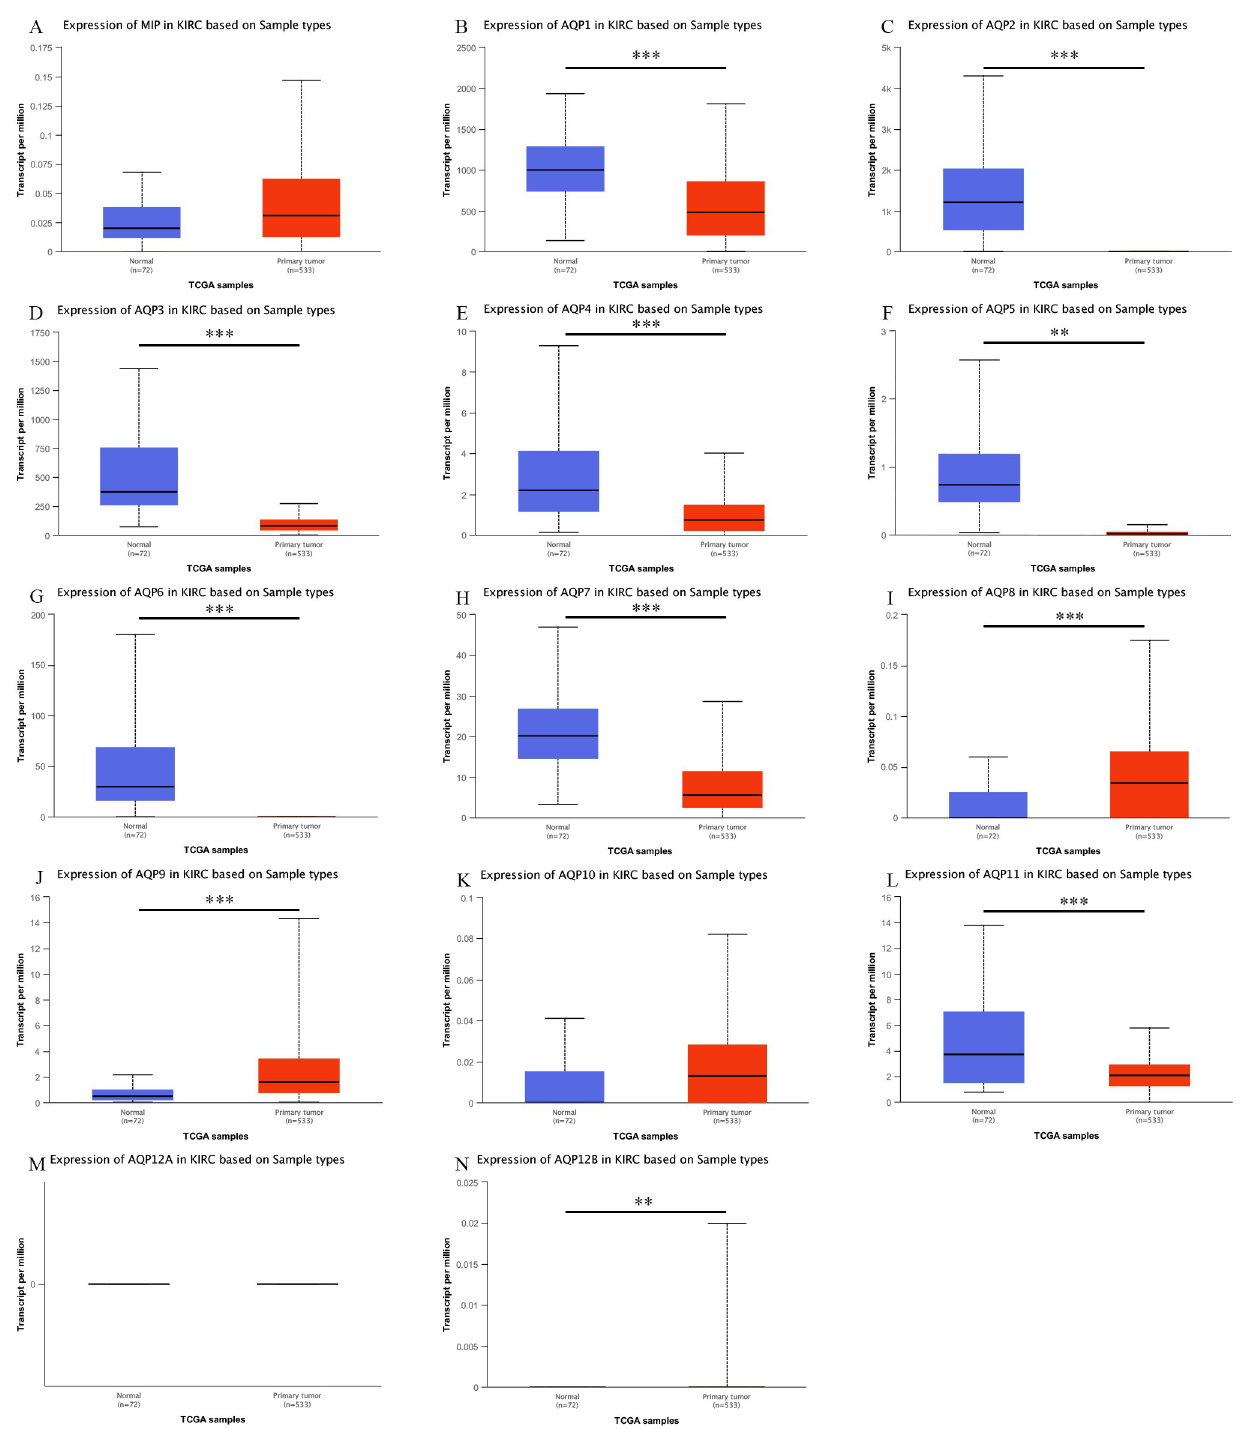
Fig 2. mRNA expression of AQPs in ccRCC and adjacent normal kidney tissues (Ualcan). mRNA expressions of AQP1/2/3/4/5/6/7/11 in ccRCC were significantly reduced while the expressions of AQP8/9/12B were significantly elevated. The p-value was set at 0.05. (A) Expression of MIP in KIRC based on Sample types. Expression of (B) AQP1, (C) AQP2, (D) AQP3, (E) AQP4, (F) AQP5, (G) AQP6, (H) AQP7, (I) AQP8, (J) AQP9, (K) AQP10, (L) AQP11, (M) AQP12A, (N) AQP12B in KIRC based on Sample types.